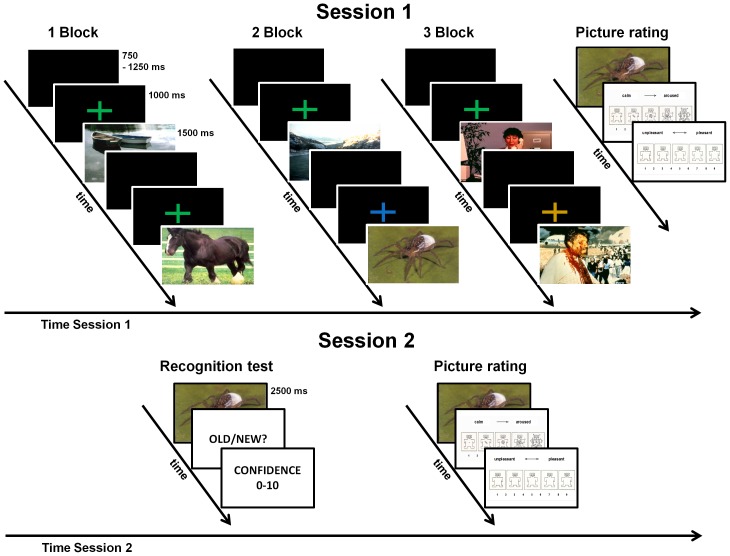
Illustration of the experimental procedure.In the first session (top) 3 separate picture blocks (neutral, spider and neutral, unpleasant and neutral) were presented in a randomized order. Within each block pictures were preceded by a fixation cross in one of three different colors that signaled the category of an upcoming picture. At the end of this session pictures were rated for valence and arousal. In the second session (bottom) old and new pictures were presented and participants were asked to decide for each picture whether it has been presented before in the study or not (OLD/NEW?) and to rate their confidence (0–10). Finally, new pictures were rated for valence and arousal.